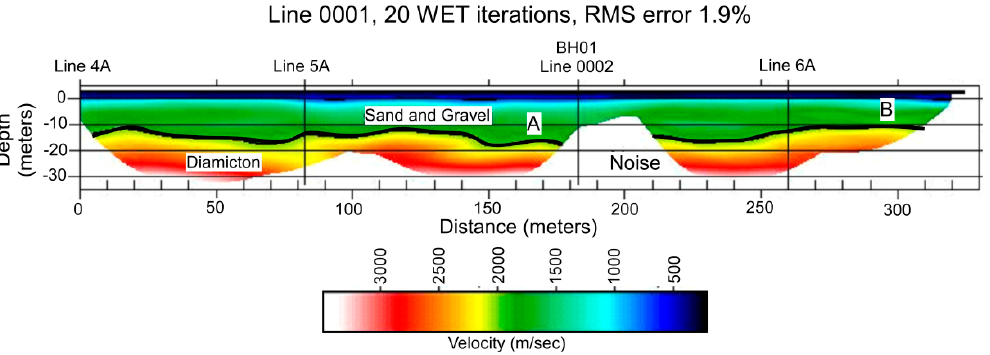
Figure 8. North-South velocity profile through Line 0001, which runs through the center of the study area. South is to the left. Here the channel is non-distinct, and runs from the about 20–260 m from the south end of the profile and is not more than 20 m deep. A = channel; B = terrace.